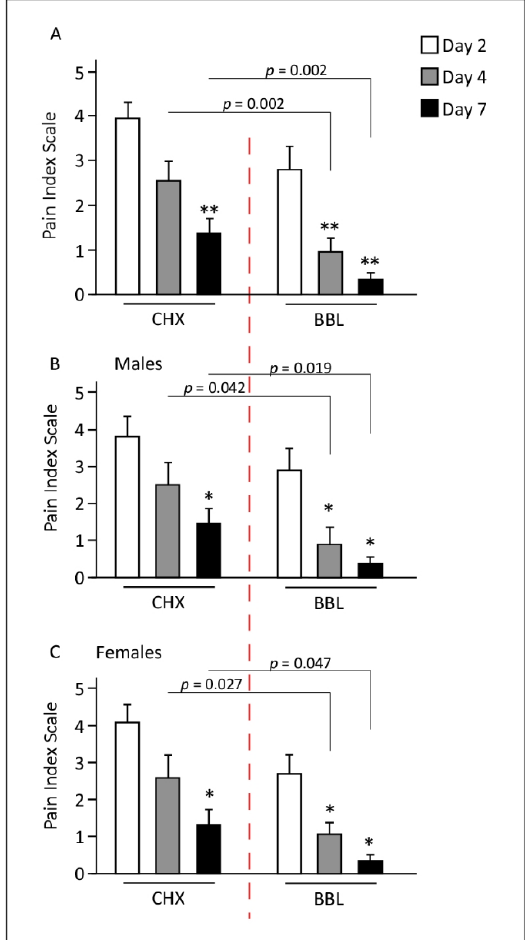
Figure 1. Pain visual analog scale (VAS) scores were reposted at days 2, 4, and 7 from the day of surgery. ( A ) Both CHX and BBL groups showed significant improvements in pain scores, though the BBL group VAS scores were significantly improved relative to the CHX group. ( B , C ) Study comparing between genders. Males and females responded similarly for both treatments, and the VAS response trend was comparable. * p < 0.05; ** p < 0.002.